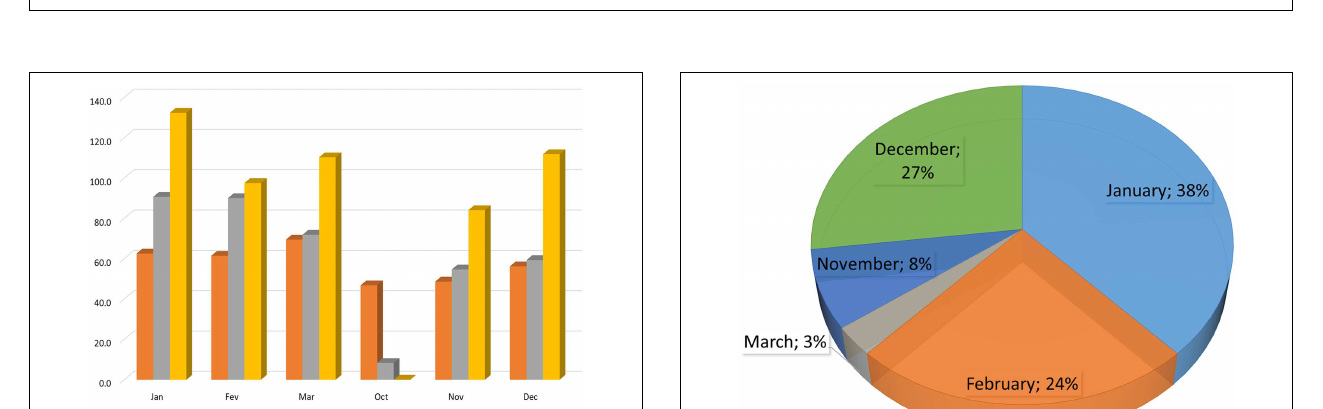
FIGURE 7 | Duration (in days) of each SACZ event: actual (line), and detected by the criterion for the LIB (hatched bar) and PRE (gray bar) series.